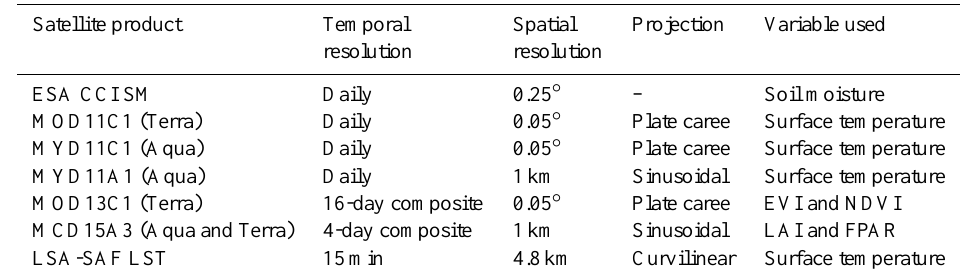
Table 2. Descriptions of the satellite-based products used in this study.